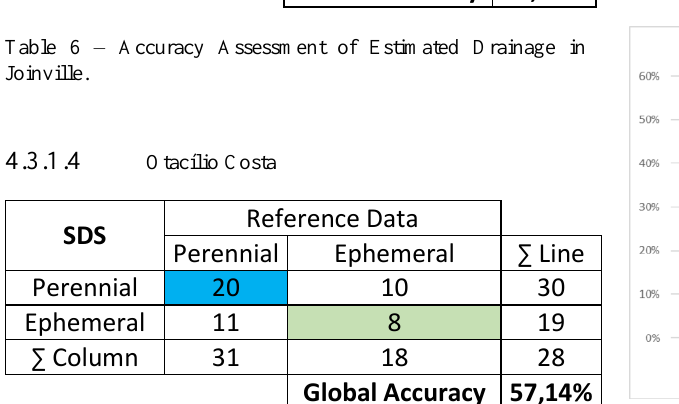
Table 7 – Accuracy Assessment of SDS/SC base in Otacílio Costa.